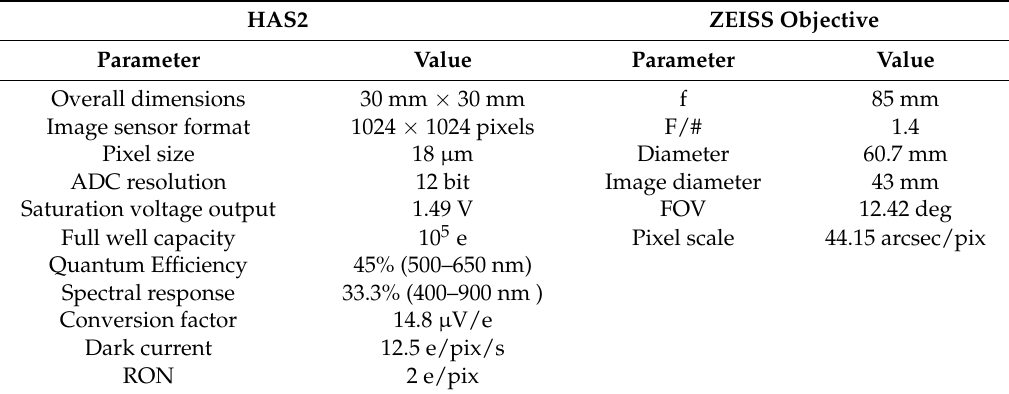
Table 3. List of main characteristics of HAS2 star tracker and ZEISS Planar T 1.4/85 objective.